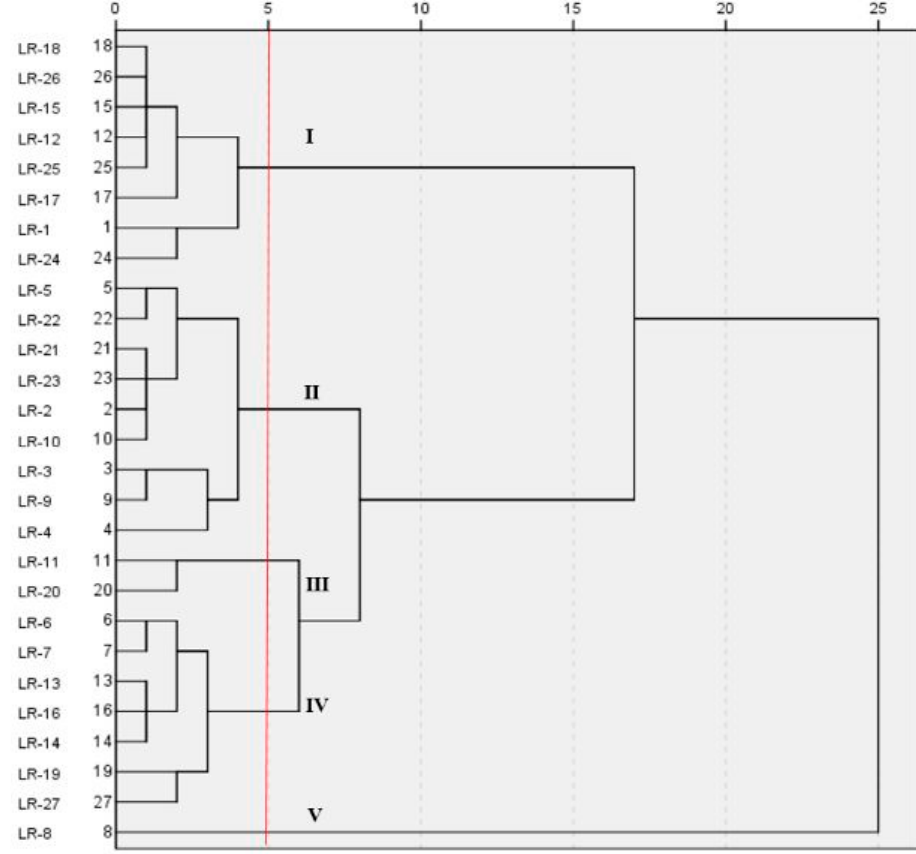
Figure 6. Cluster pattern of late rice cultivars on the basis of Cd accumulation in polished rice.